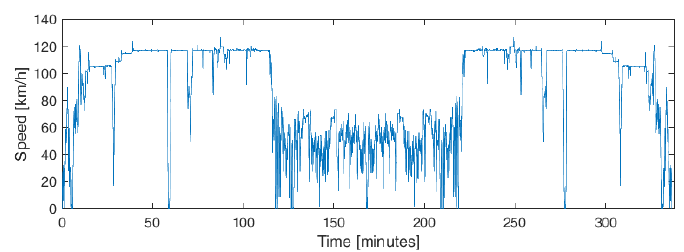
Figure 22. Speed profile, highway-mountain.